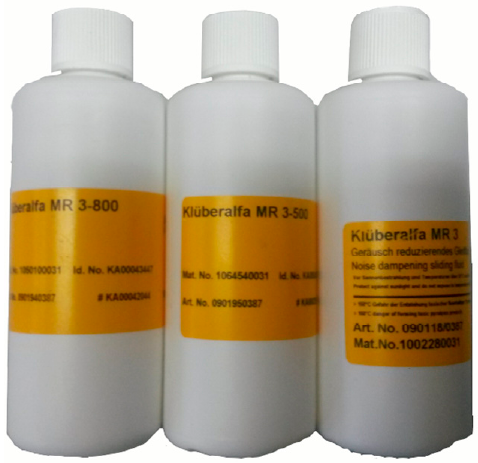
Figure 5. Vernier caliper. The resolution of the vernier caliper is 0.01 mm.